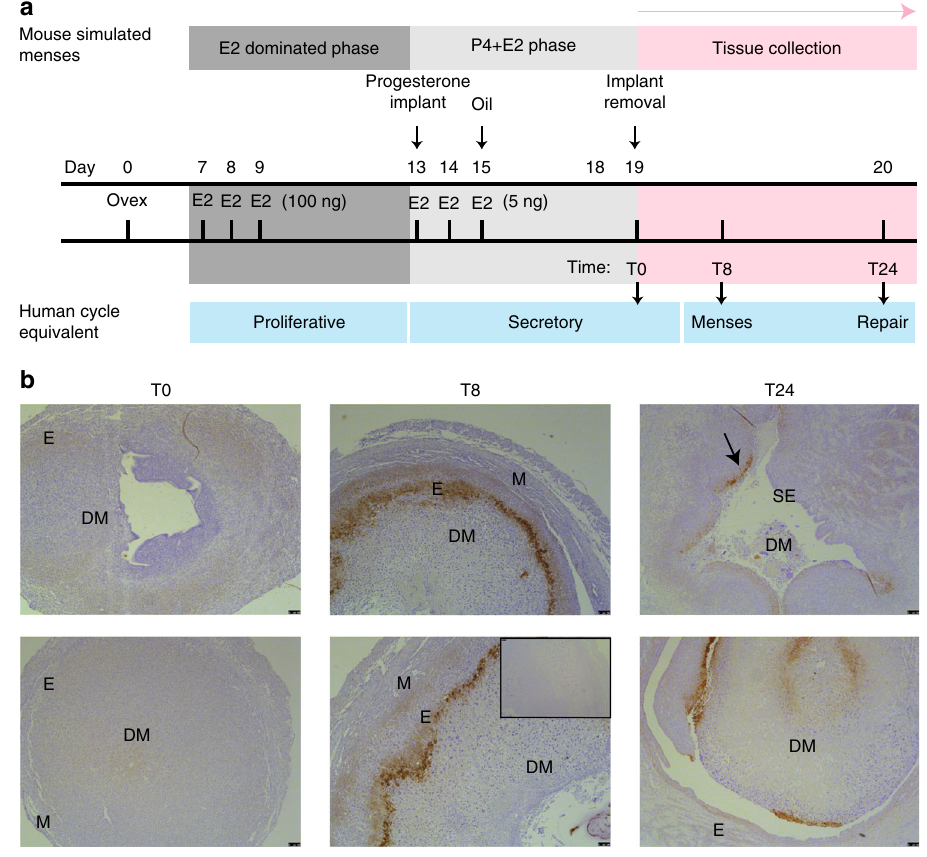
Fig. 2 The mouse model of simulated menstruation reveals physiological hypoxia at menses. a Murine model of simulated menstruation. E2 estradiol, P 4 progesterone, Ovex ovariectomy. T0 time of P4 implant removal, T8 8 h following progesterone withdrawal, T24 24 h following P4 withdrawal. b Representative endometrial pimonidazole staining from two mice T0, T8 and T24 (inset = negative control). Total replicates T0 ( n = 4), T8 ( n = 7) and T24 ( n = 11). DM decidualised mass, E endometrium, M myometrium, SE surface epithelium. Arrow indicates positive staining in endometrium that has not yet reepithelialised. Scale bar = 100 μ